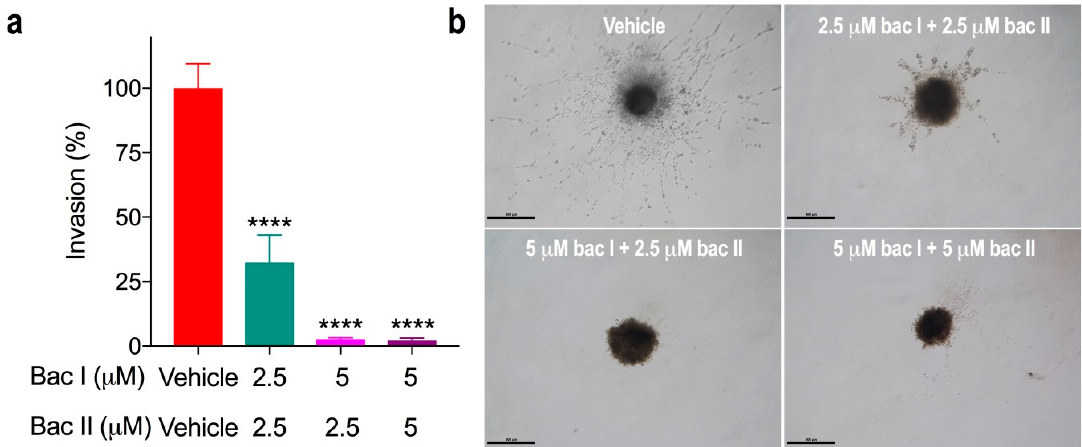
Figure 6. Non-cytotoxic combinations of bac I and II reduced MDA-MB-231 invasion in the spheroid invasion assay. MDA-MB-231 cells formed spheroids for three days prior to being embedded in the invasion matrix and treated with the vehicle, or bac I and bac II. The size of the spheroid was measured using NIS-Elements software (Nikon) daily for up to 4 days. ( a ) Invasion on day 3 of treatment was normalised to the average vehicle and expressed as the mean ± SD of three replicate wells. P-values are relative to the vehicle **** p < 0.0001). ( b ) Representative microscopic images (40x magnification; scale bar = 500 μ m).